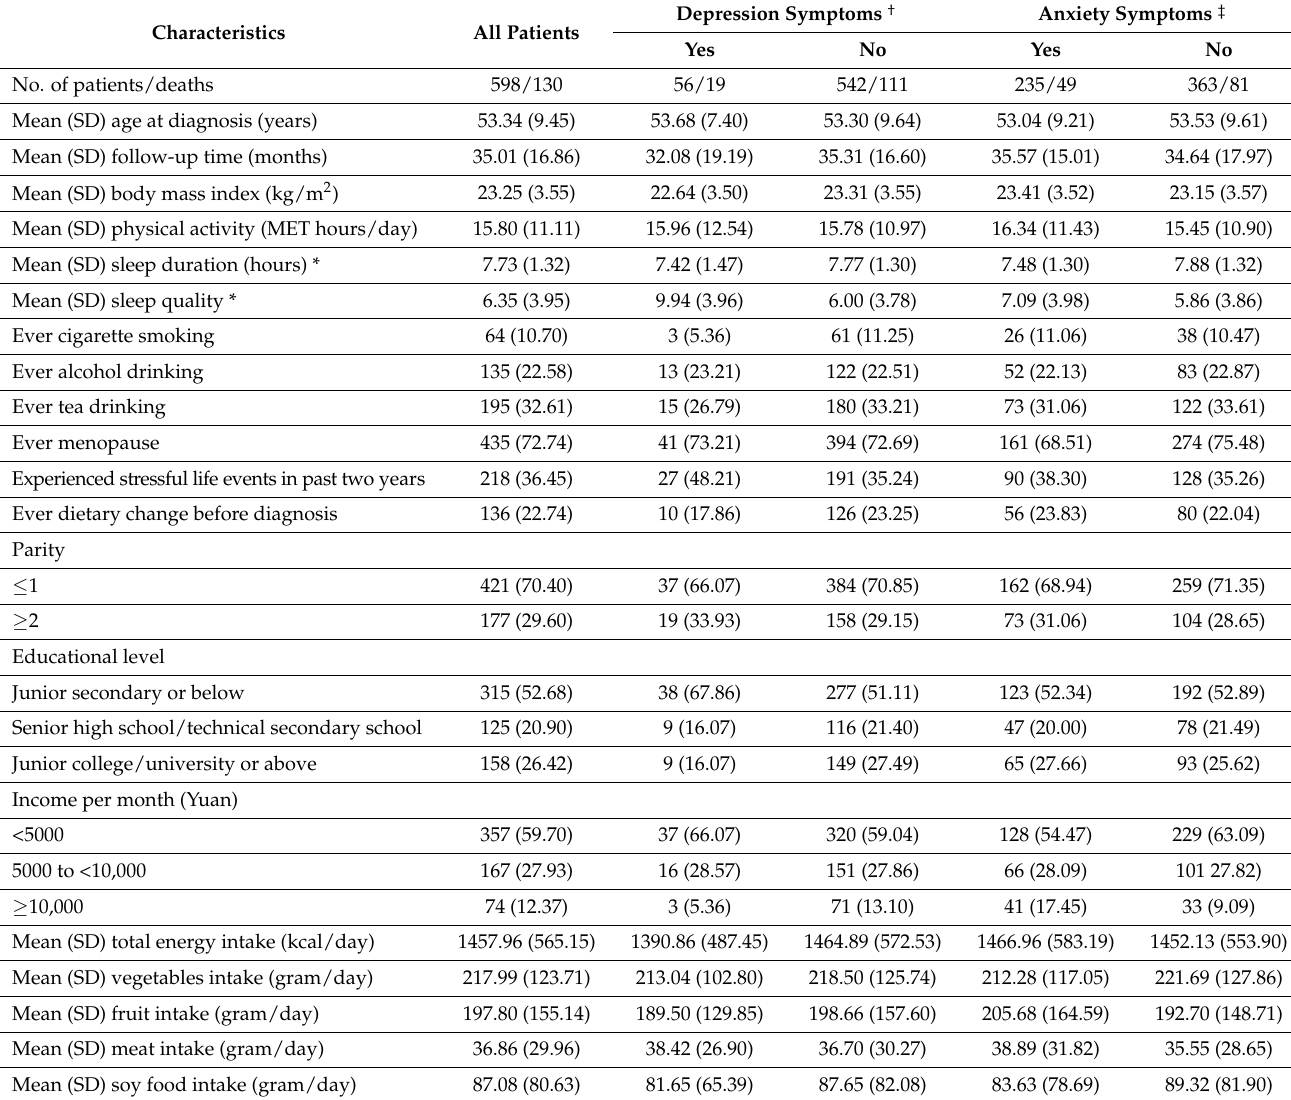
Table 1. Baseline characteristics of ovarian cancer patients by depression and anxiety symptoms ( n =